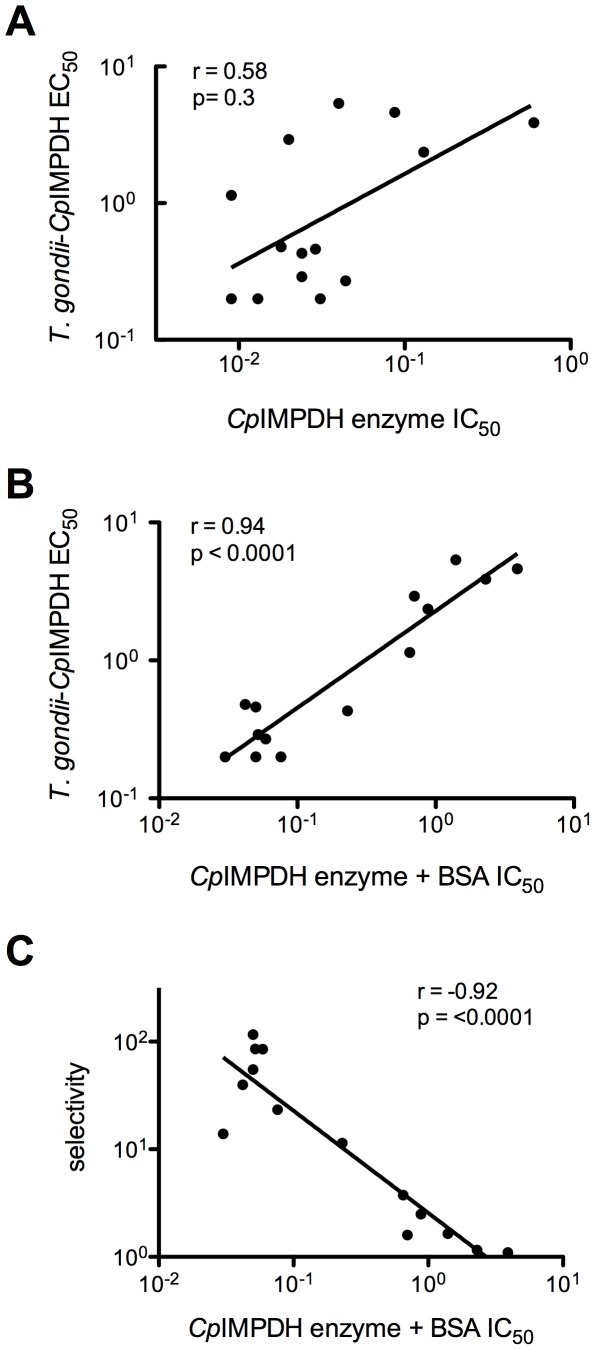
Correlation between CpIMPH enzyme inhibition and potency and selectivity in the T. gondii-CpIMPDH model.
A shows a relatively weak (r = 0.58) and statistically insignificant (p-value = 0.3) correlation between the triazole compound IC50 values for the CpIMPDH enzyme inhibition and the EC50 for proliferation of the T. gondii-CpIMPDH parasite. However, a strong, positive correlation exists between the potency of CpIMPDH enzyme inhibition when assayed in the presence of BSA and inhibition of T. gondii-CpIMPDH proliferation (r = 0.94, p<0.0001; B). C, shows that selectivity in the T. gondii model, determined by the relative inhibition of the T. gondii-CpIMPDH parasite over wild-type T. gondii, also correlates well with the potency of enzyme inhibition in the presence of BSA (r = −0.92, p<0.0001).